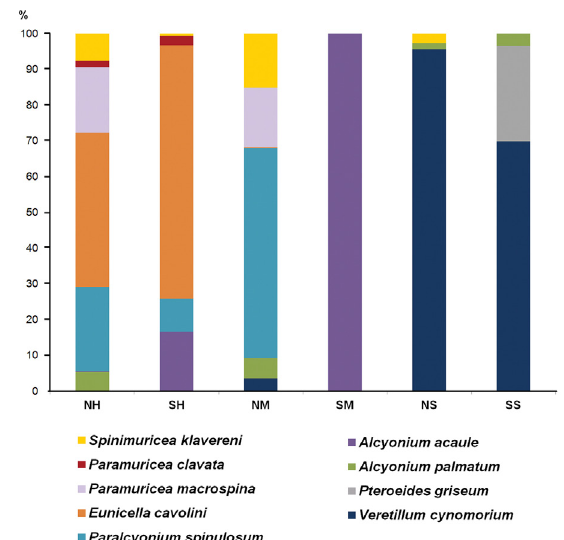
Fig. 2. – PCO plot of the relationships between sampling stations Fig. 3. – Percentage composition of the coral assemblages at hard based on species composition data. The acronyms for substrate substrate stations of the north (NH) and south (SH); at mixed sub- types are as follows: hard substrate composed of hard beds and strate stations of the north (NM) and the south (SM); at soft sub- rocks (H), soft substrate composed of sandy/muddy bottom (S), and strate stations of the north (NS) and south (SS). mixed substrate composed of pebbles, shells and small rocks on muddy bottom (M).